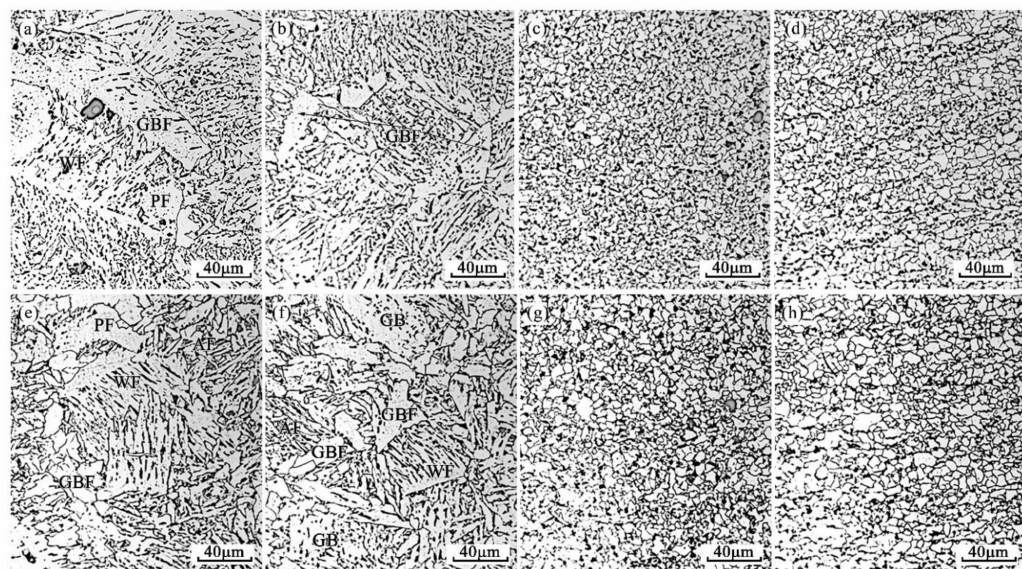
Figure 7. Microstructures of HAZ for No.1 steel. ( a – d ) CGHAZ, FGHAZ and ICHAZ under W1 procedure, ( e – h ) CGHAZ, FGHAZ and ICHAZ under W2